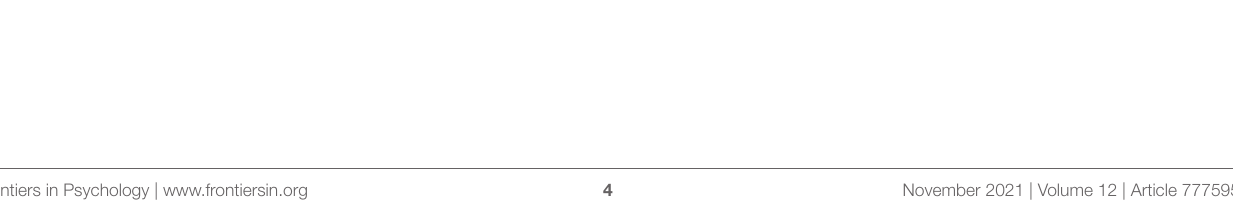
Frontiers in Psychology | www.frontiersin.org